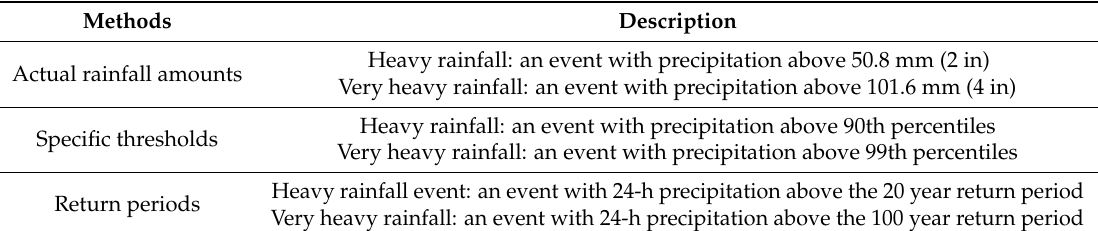
Table 1. Definition of heavy and very heavy rainfall used in this